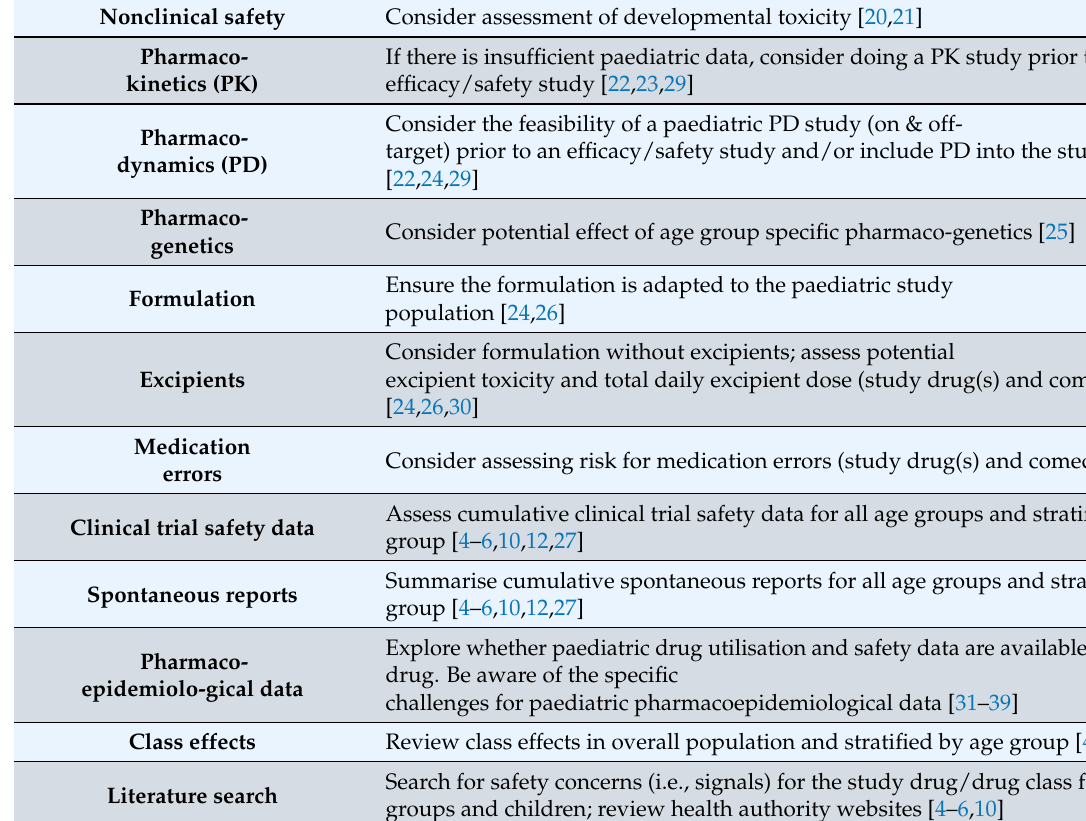
Data Available for * Children But Not Age Age Group of Adults Group of Study Paediatric Study Population Population